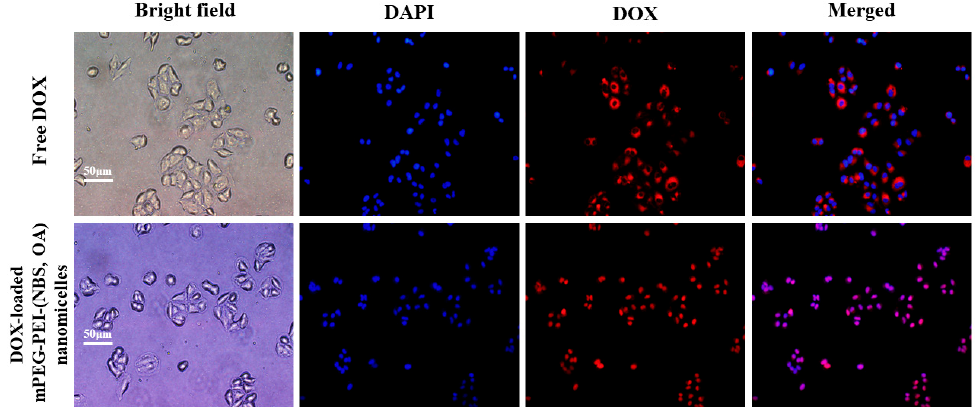
Figure 11. Fluorescence images of A549 cells incubated with free DOX and DOX-loaded mPEG-PEI-(NBS, OA) upconversion nanomicelles. The images from left to right show bright field (gray), cell nuclei stained by 4,6-diamidino-2-phenylindole (DAPI) (blue), DOX fluorescence (red) and overlays of the red and blue images.